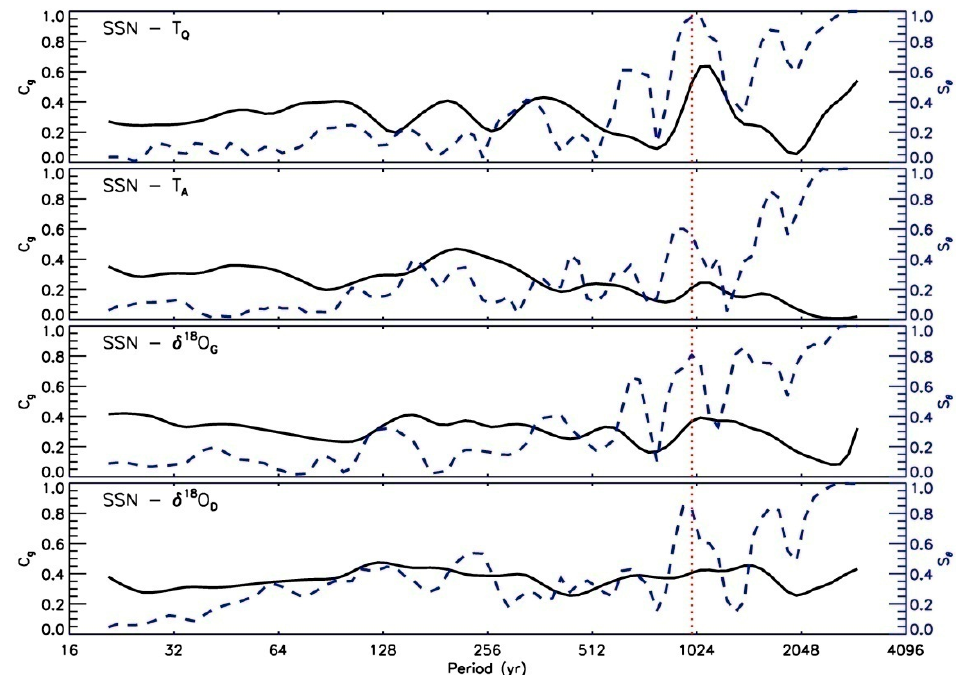
Figure 3. The global wavelet coherence (C g , solid line) and phase angle strength ( S θ , blue dashed line) between SSN and climate indices plotted against period; The vertical dotted lines mark the 1000-year period.